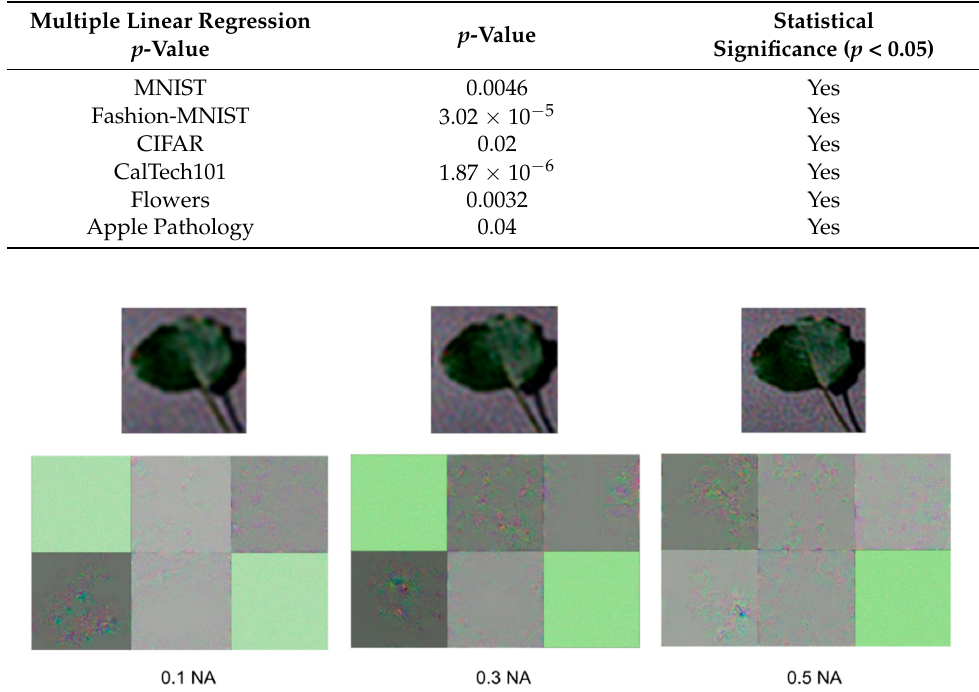
Table 4. F-Test p -values for multiple linear regression between image classification accuracy, PSNR, and SSIM for MNIST, Fashion-MNIST, CIFAR, CalTech 101, and the flowers and apple pathology datasets.